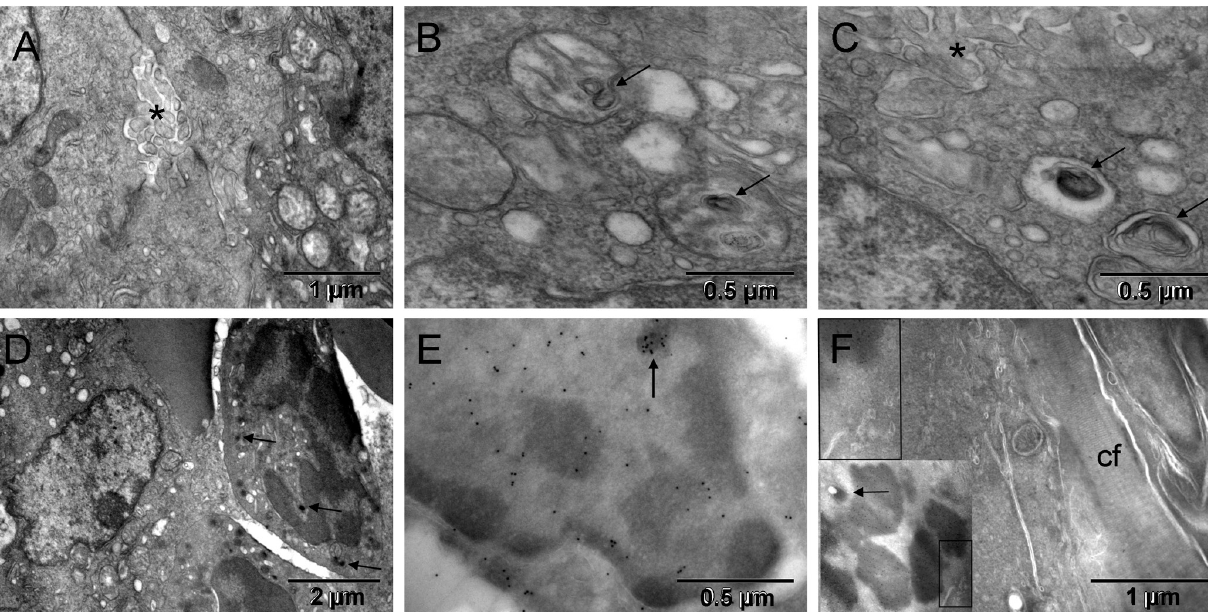
Figure 2. Hypoxia in tumor cells and involvement of host cells in forming the capsular vaso-mimicry. Hypoxia in tumor cells was manifested by structural changes of mitochondria resulting in their condensation into smaller and more electron dense (darker) forms or in degradation of cristae (left and right, respectively) [ A ], occasionally leading to autophagic vacuoles with whorls of membranes (arrows in [ B & C ]) or to peroxisomes (arrows in [ D ]). Partial separation of the tumor cells from one another (anoikis 58 ) with emergence of meandering nanotentacles (stars in [ A & C ]) created intercellular passages and greatly increased the cell surface. Immunocytochemical detection of GFP- labeled histone H2B in tumor cells is shown in [ E & F ]. The tumor cell in [ E ] had a nucleus with electron dense regions that did not contain H2B, except for a small upper region, demonstrating incomplete chromatin degradation (arrow). Upper left corner of [ F ] corresponded to the boxed area of the insert and showed H2B specific label in mitotic chromosome of the tumor cell. A layer of collagen fibers (cf) separated that cell from the elongated fibroblast with unlabeled nucleus (upper right corner) of [ F ]. Arrow in the insert points to a condensed